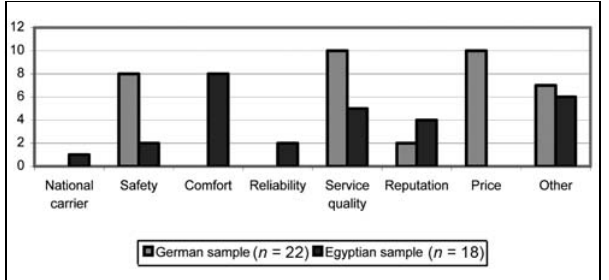
Fig 5. EgyptAir’s website: Colour and symbols